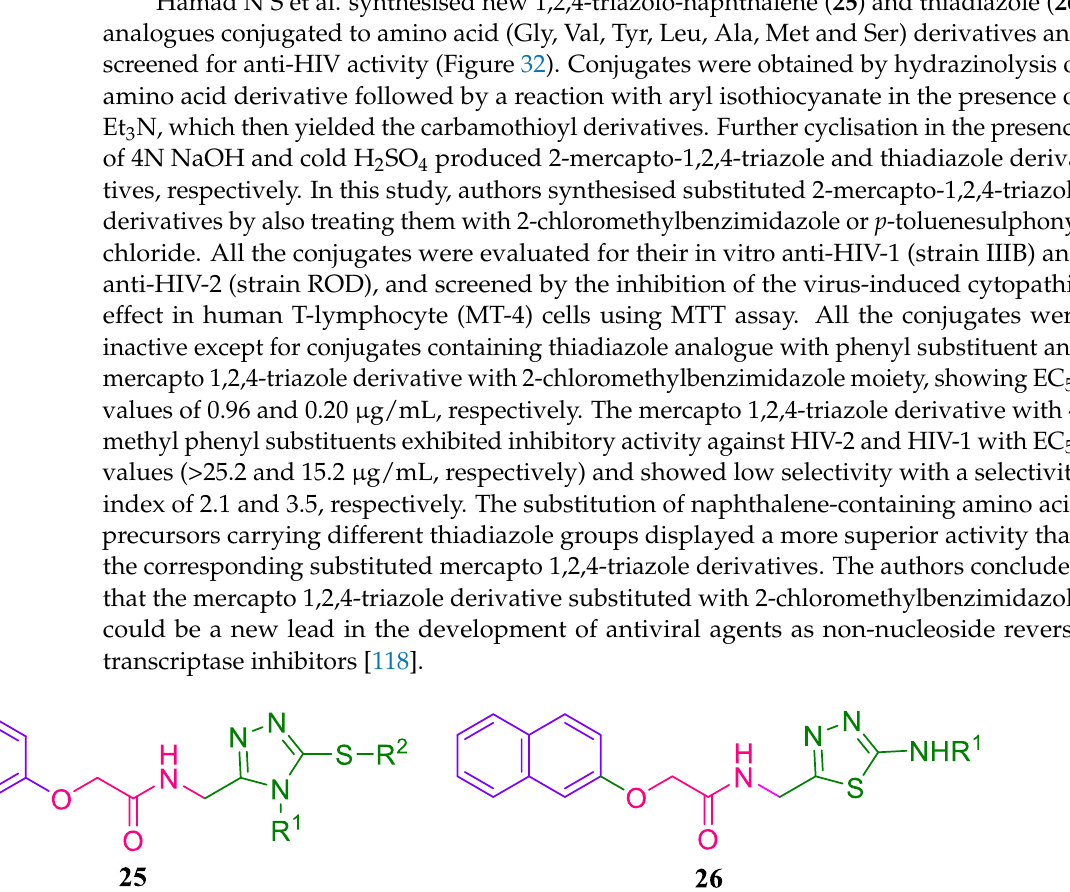
Figure 31. Amino acids conjugated to piperoyl derivatives.